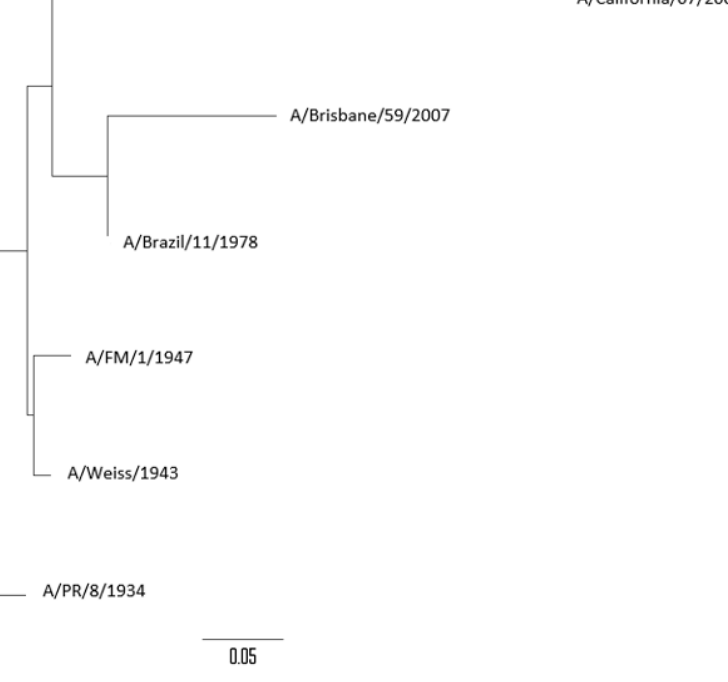
Figure 4. Phylogenetic tree of the neuraminidase (NA) gene of influenza A(H1N1) strains analyzed.